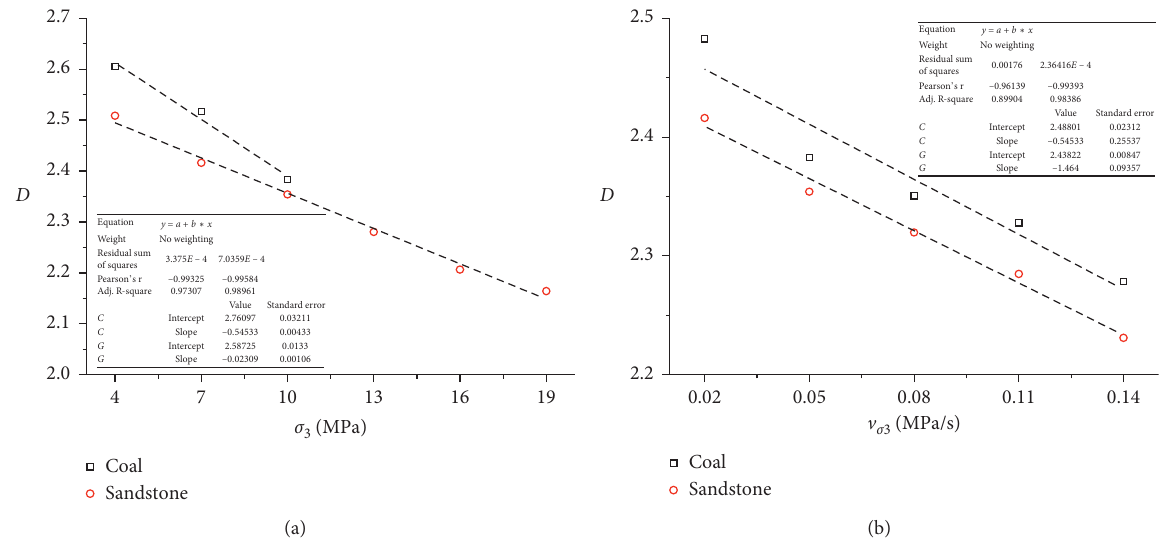
Figure 12: Effects of unloading conditions on the fractal dimension of fragmentation. (a) Fractal dimension with different initial unloading confining pressures. (b) Fractal dimension with different unloading